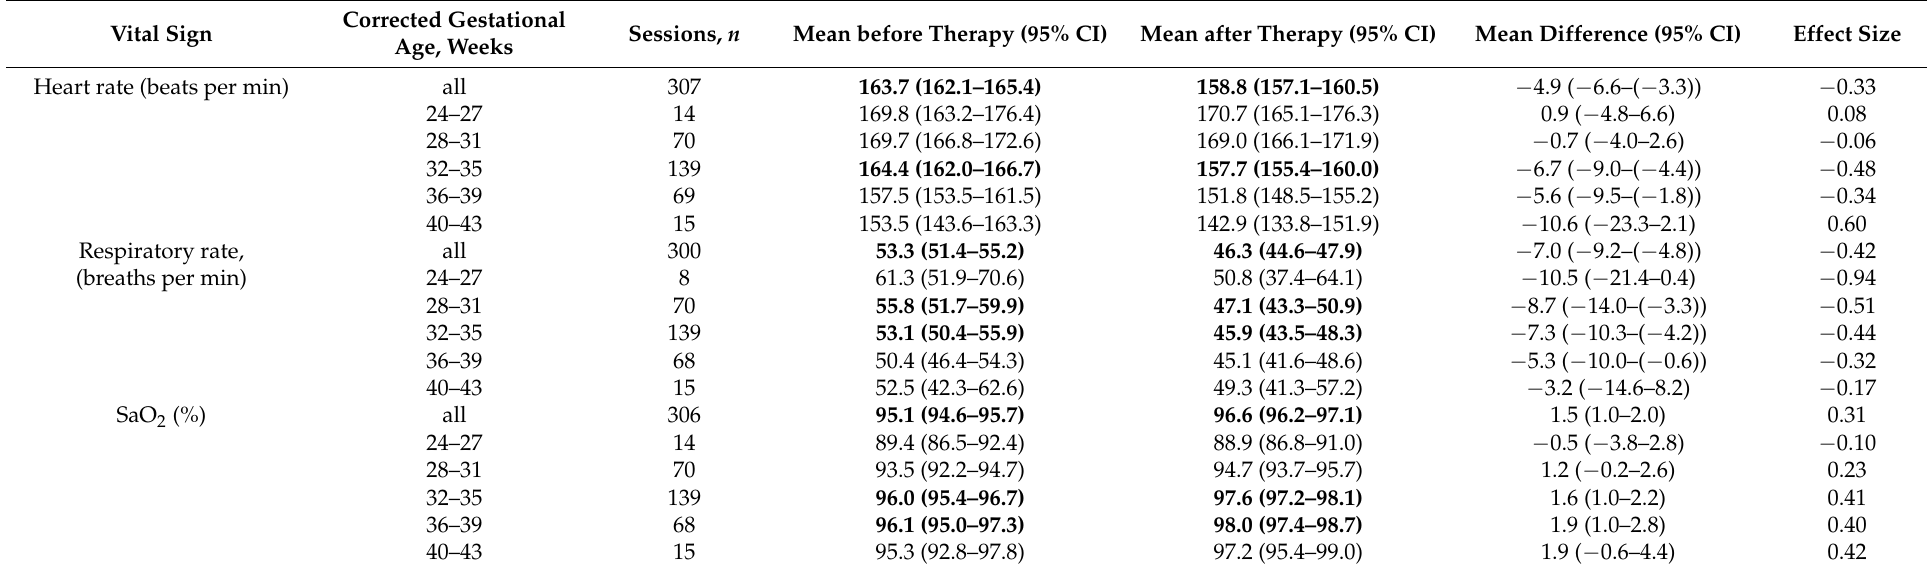
Table 2. Heart rate, respiratory rate and oxygen saturation during music therapy